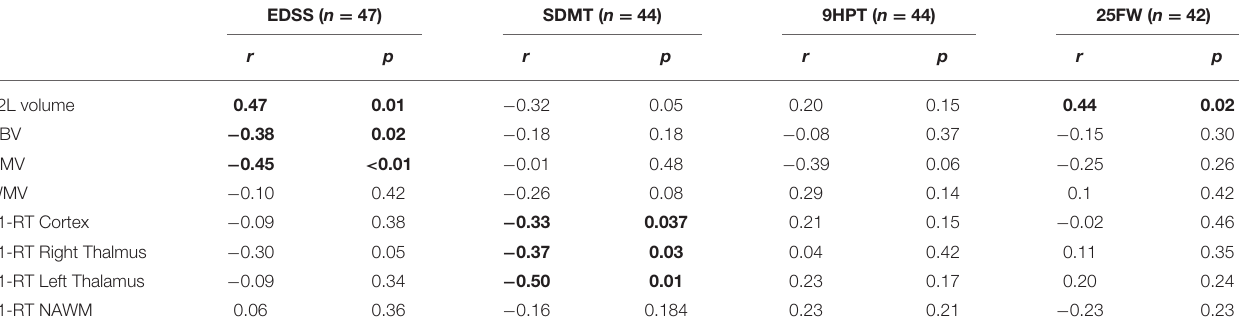
TABLE 2 | Spearman rank correlation of MRI measures and clinical and cognitive test scores. EDSS ( n =